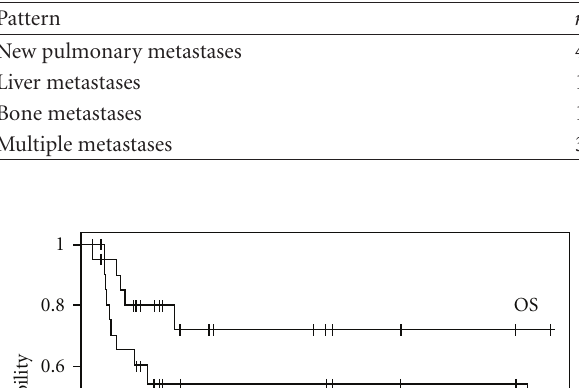
Figure 2: Kaplan-Meier curve of overall survival rates for patients with a disease-free interval (DFI) < 36 months ( n = 9) or ≥ 36 months ( n = 13). The groups’ survival rates di ff ered significantly ( P = 0 .